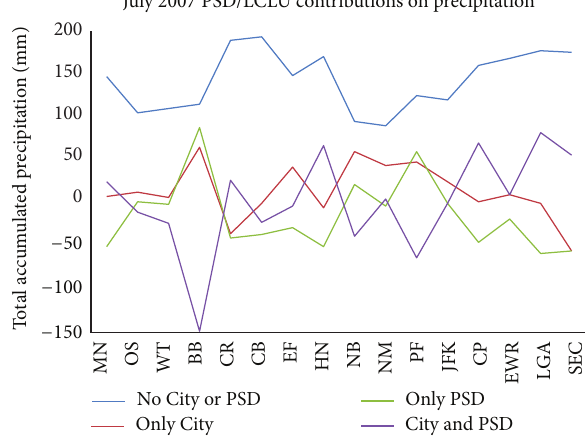
Figure 6: PSD/LCLU individual contributions on